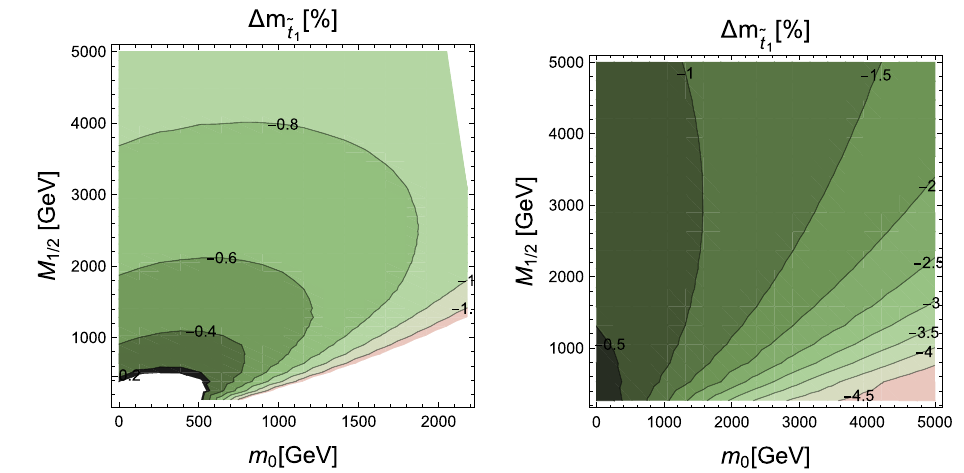
Fig. 6 The same as Fig. 5 for lightest stop but using A 0 = − 1 . 5 m 0 ( left ) and A 0 = + 1 . 5 m 0 ( right